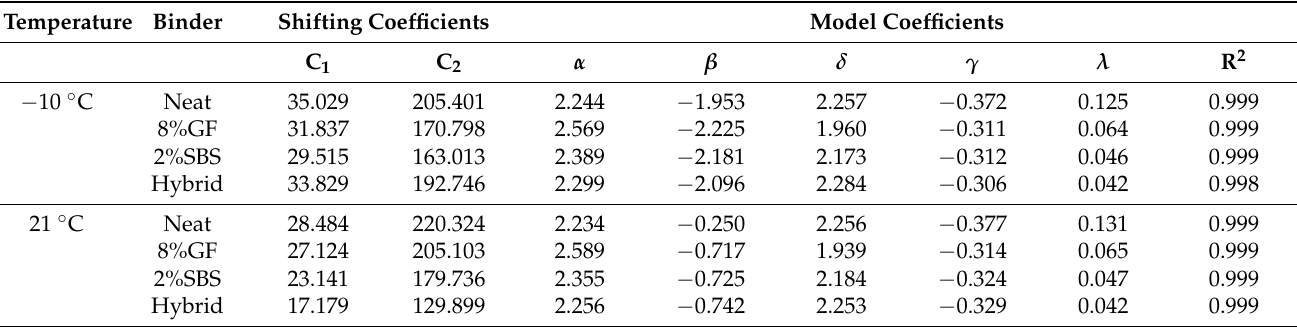
Table 7. Summary of the shift factor and sigmoidal model coefficients.